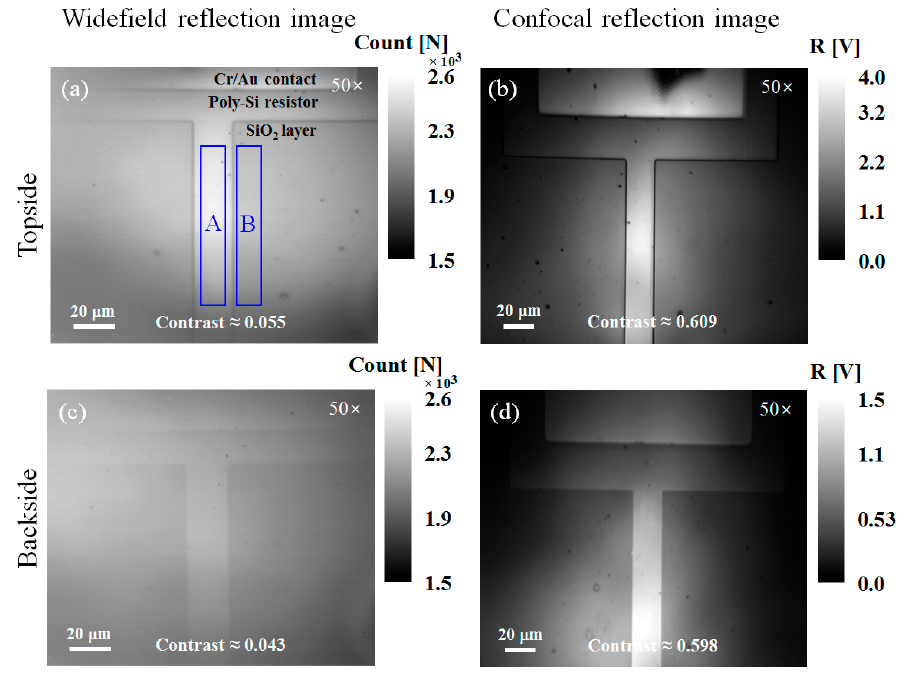
Figure 4. Topside and backside reflectance ( R ) images of the poly-Si micro resistor obtained by ( a , c ) the widefield microscope and ( b , d ) the confocal microscope with a 50× objective lens (NA 0.42).